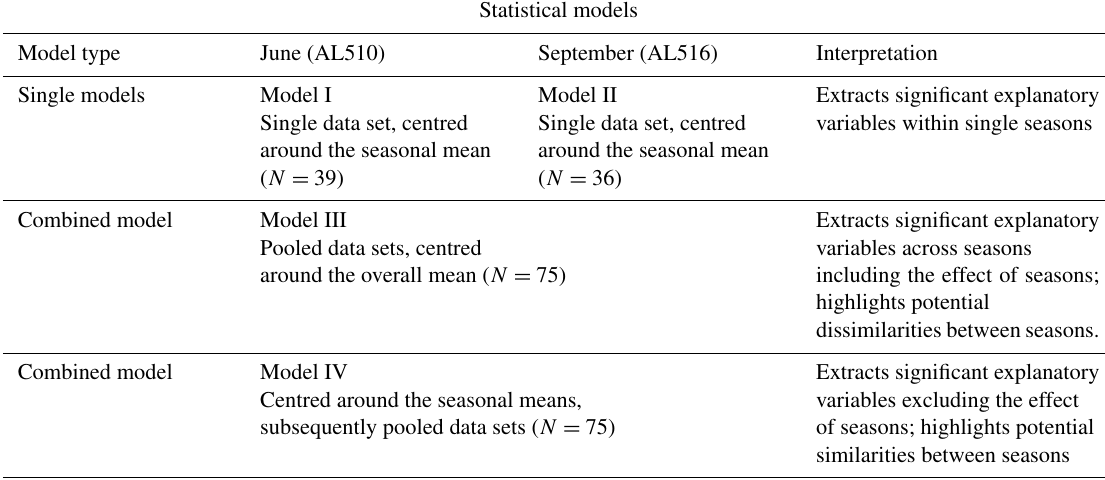
Table A1. Overview of multifactorial regression models applied to assess surfactant dynamics within and across seasons.